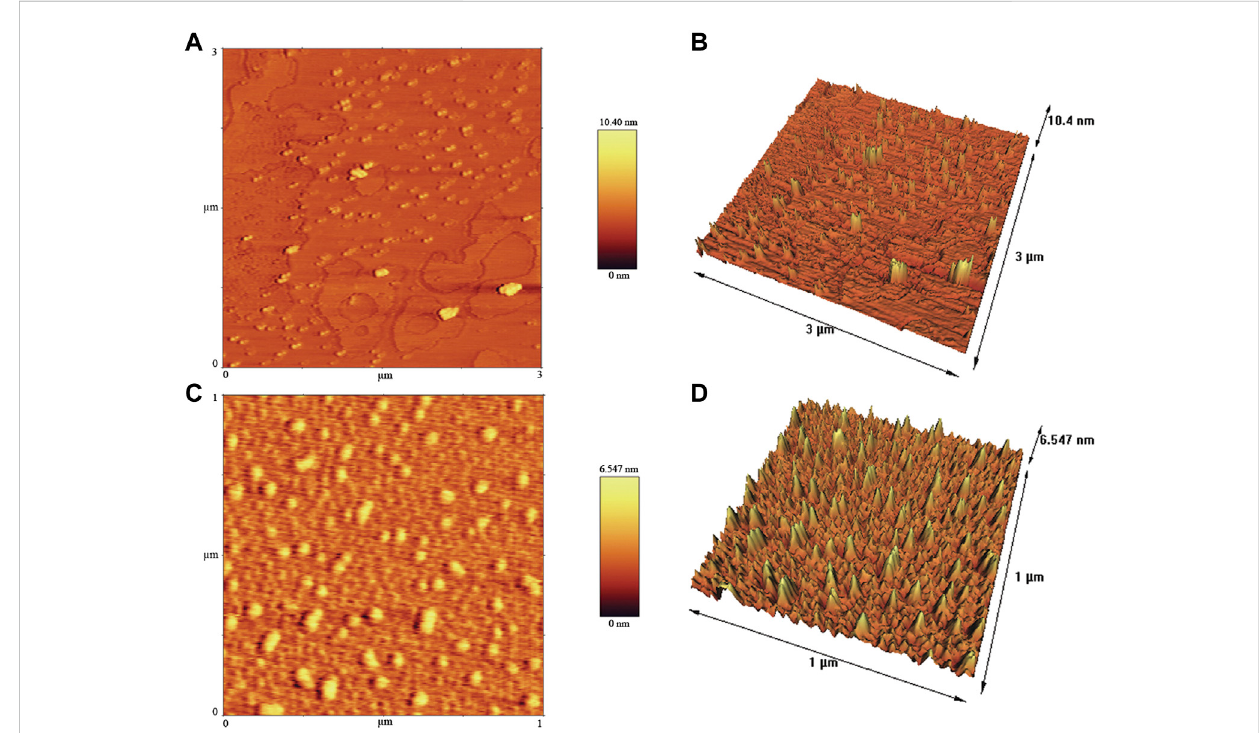
AFM images of crude (A, B) and calcined (C, D) CuONPs: 2D view (A, C) and 3D view (B, D) .